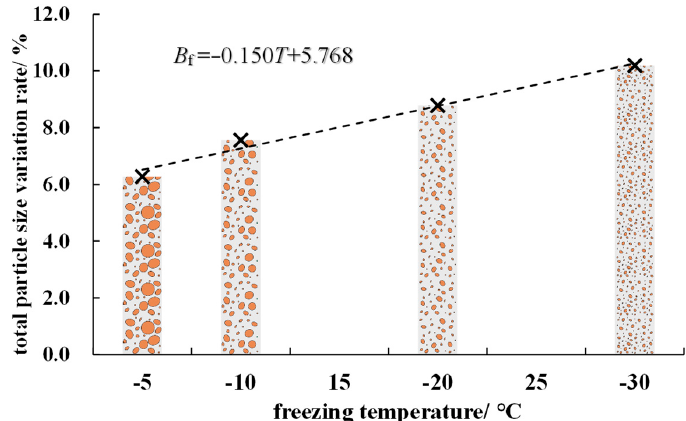
Figure 16. The effect of freezing temperature on the total particle size of silt.